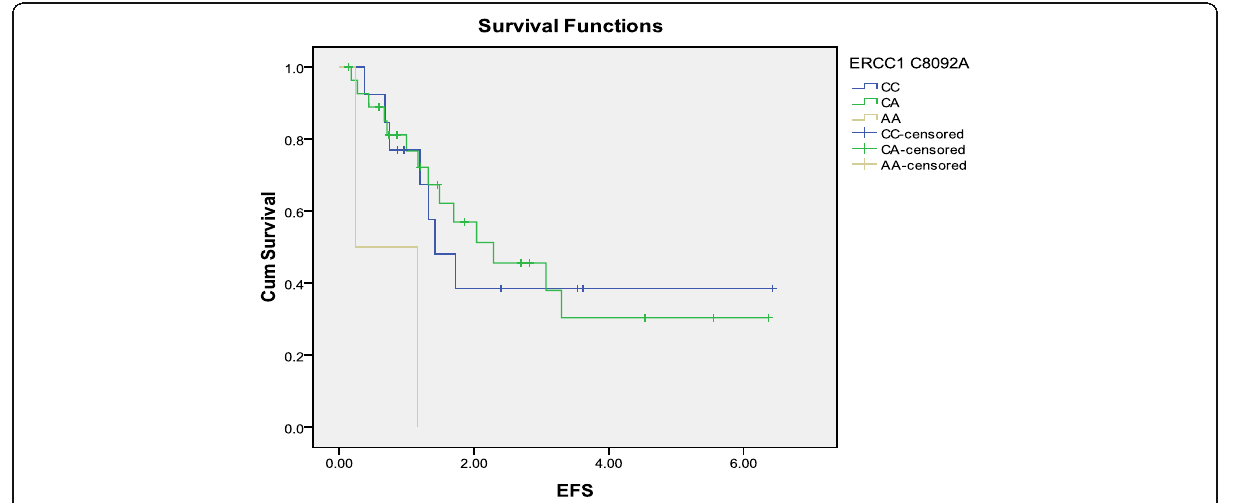
Fig. 1 Kaplan-Meier plot of EFS (Years) according to ERCC1 C8092A